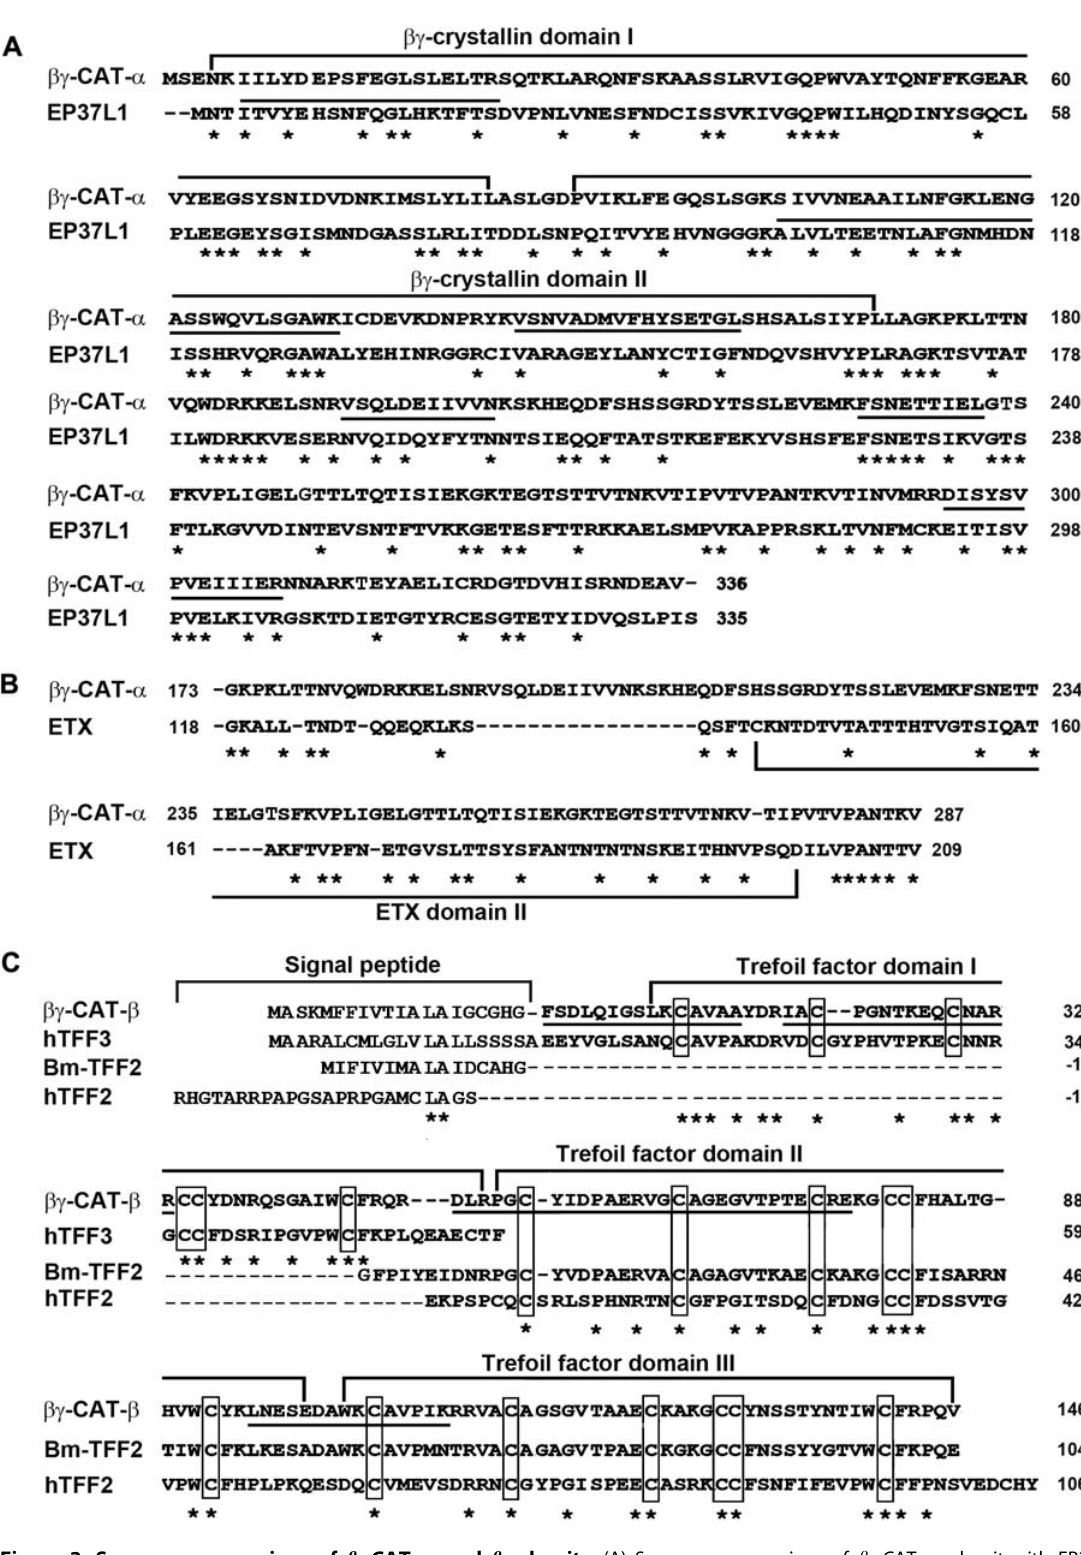
Figure 3. Sequence comparison of bc -CAT a - and b -subunits. (A) Sequence comparison of bc -CAT a -subunit with EP37L1 from newt C. pyrrhogaster [2]. The characteristic bc -crystallin domains were marked. (B) Sequence comparison of bc -CAT a -subunit C-terminal part (residues 173– 287) with an internal fragment (residues 118–209) of ETX from bacterial C. perfringens [21]. (C) Sequence comparison of bc -CAT b -subunit with human TFF3 [22], Bm-TFF2 [12] and human TFF2 [23]. The characteristic cysteine residues of TFF domains are boxed. In (A) and (C), Peptides corresponding to determined amino acid sequences by Edman degradation are underlined. In (A), (B) and (C), identical residues are shown by asterisks. Gaps have been introduced to optimize the sequence homology.